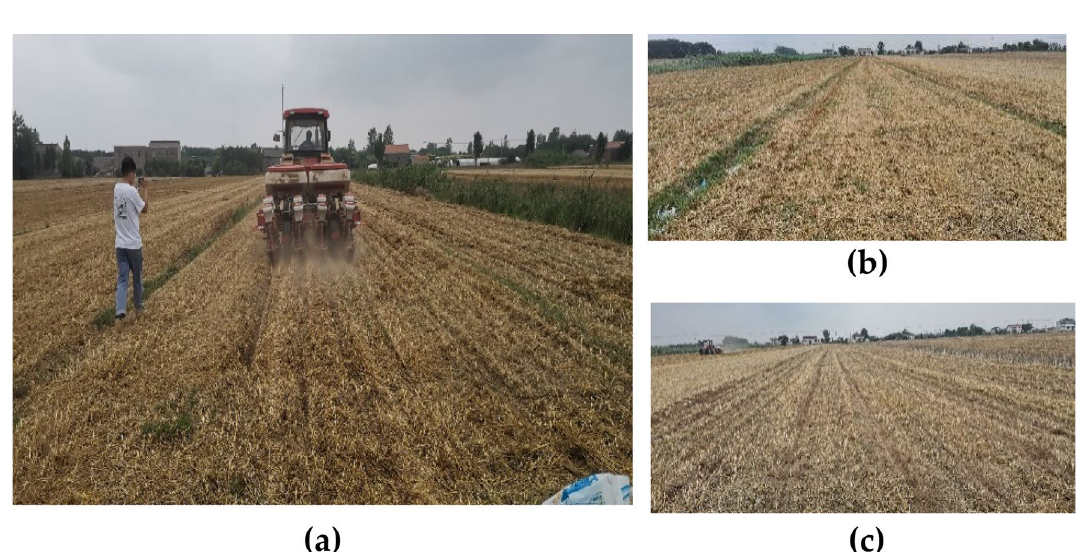
Figure 11. Field experiment under inclined seed-metering. ( a ) In-situ operation of the inclined seed-metering device; ( b ) field view before operation; ( c ) field condition after operation of the metering device.